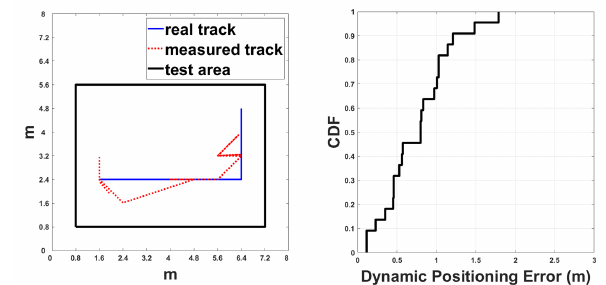
Figure 11. Dynamic positioning and the CDF of